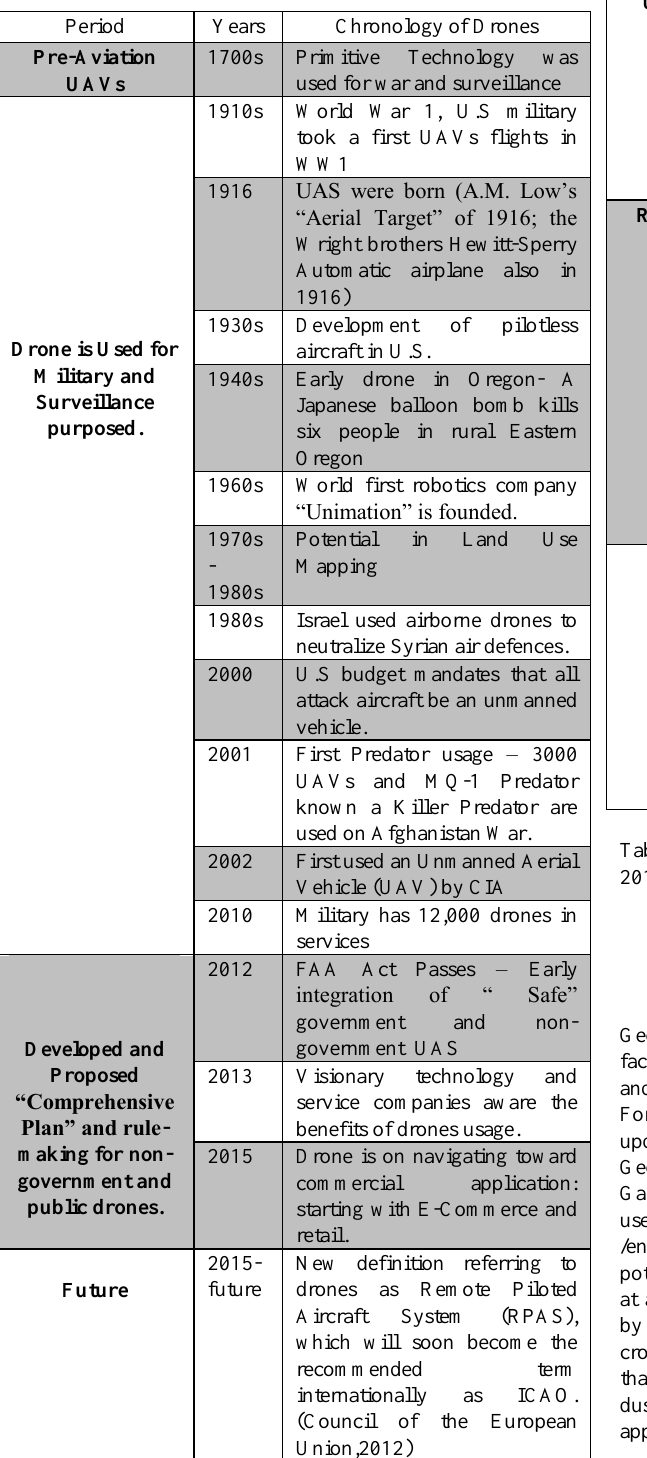
Table 1: The Evolution of Drones Function